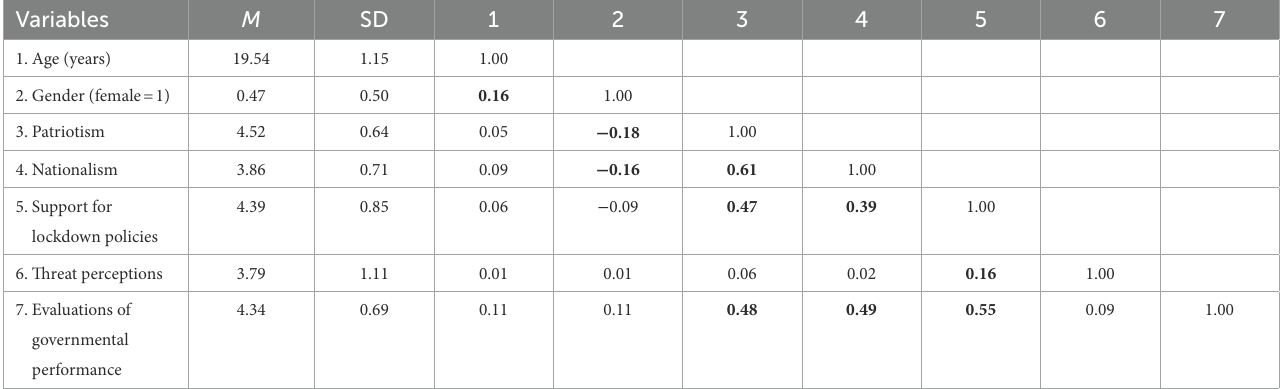
TABLE 1 Means, standard deviations, and zero-order correlations between the variables.